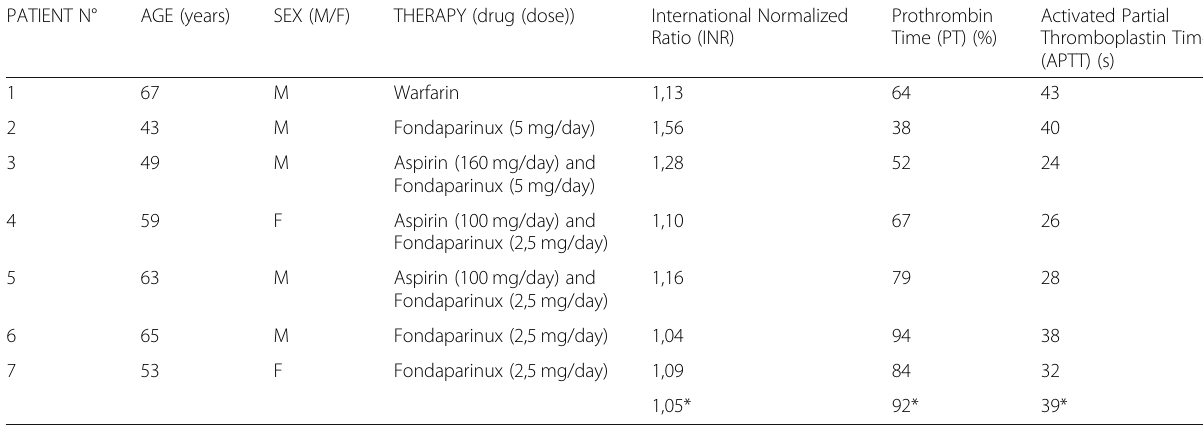
Table 1 Patients cohort with antithrombotic therapy and coagulative profile at the time of bleeding (* second bleeding) PATIENT